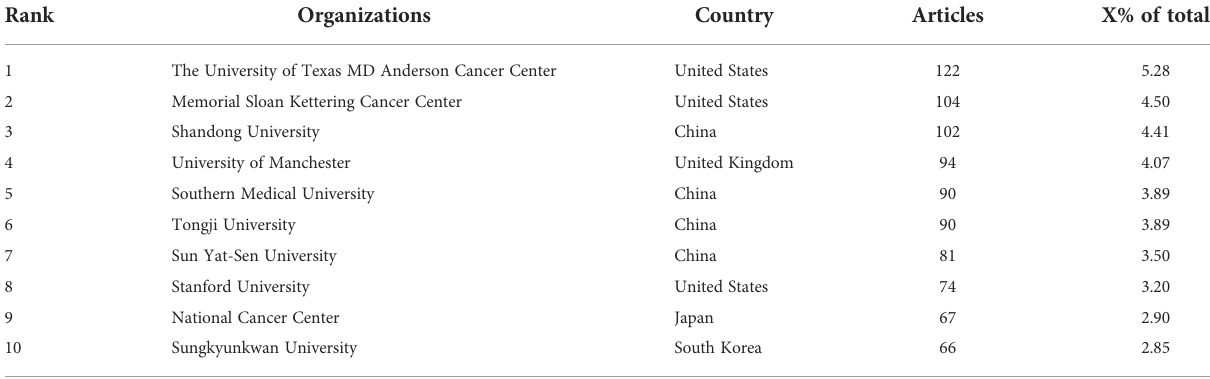
TABLE 2 The top 10 institutes that contributed to articles about SCLC.